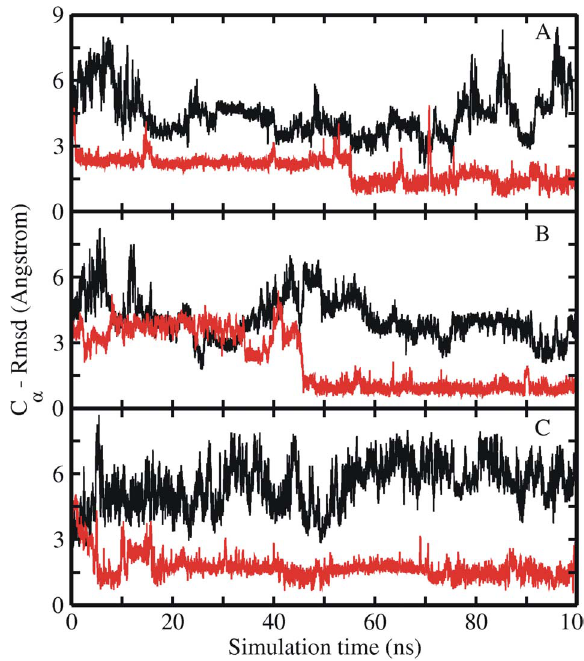
Figure 8. Free and restrained MD simulations of intermediate Trp-cage structure. RMSD C a with respect to the native Trp-cage structure starting from an intermediate state (of set 2) with (red lines) and without (black lines) side chain dihedral angle restraints on Trp6 residue vs. simulation time. Results are shown for three different force fields (A) ff03, (B) ff99SB and (C) ff99SB_NMR.